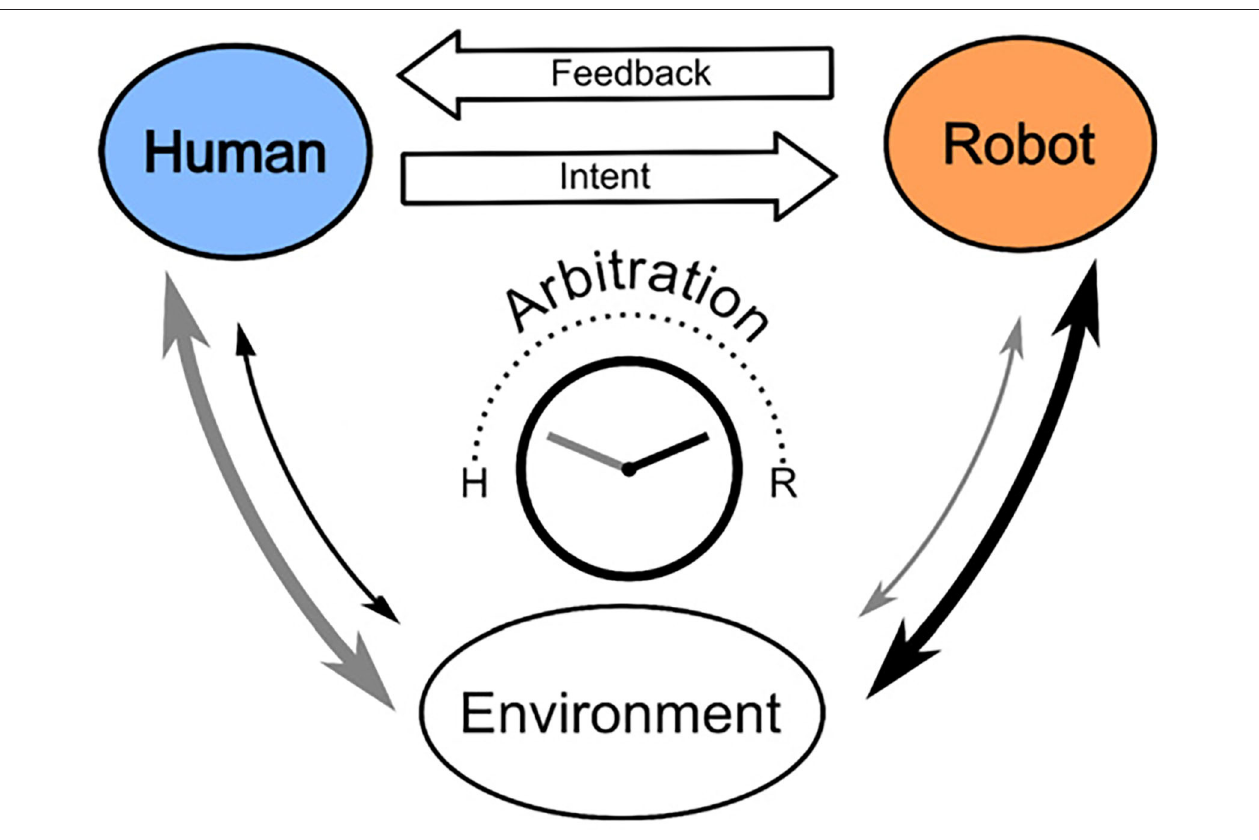
FIGURE 1 | Adapted from Losey et al. (2018). A scheme of the interplay between robot feedback and human intention in physical human-robot interaction (pHRI). Humans receive feedback from the robot (controller) system once it decodes human task-specific intention. The robot and the human jointly exert control on the environment where the degree of control from either is determined through arbitration for a given